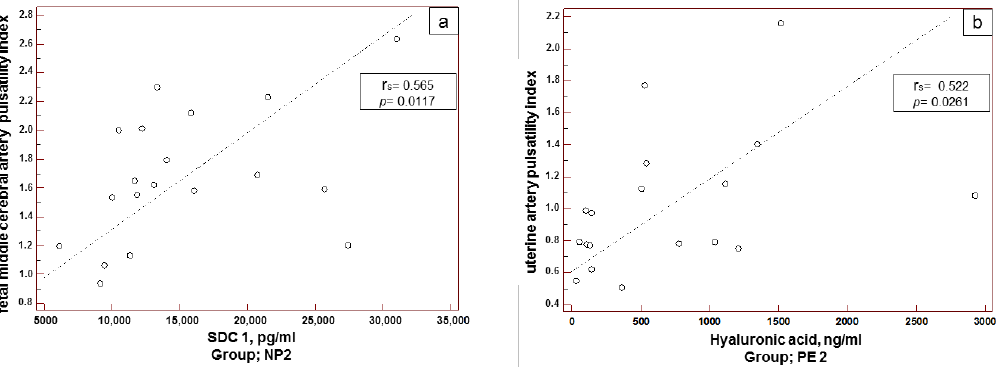
Figure 3. Correlation between proteoglycan/glycosaminoglycan concentrations and dopplerometric parameters in healthy pregnancy of ≥ 34 weeks ( a ); in late-onset PE ( b ). Statistical analysis with Spearman correlation.